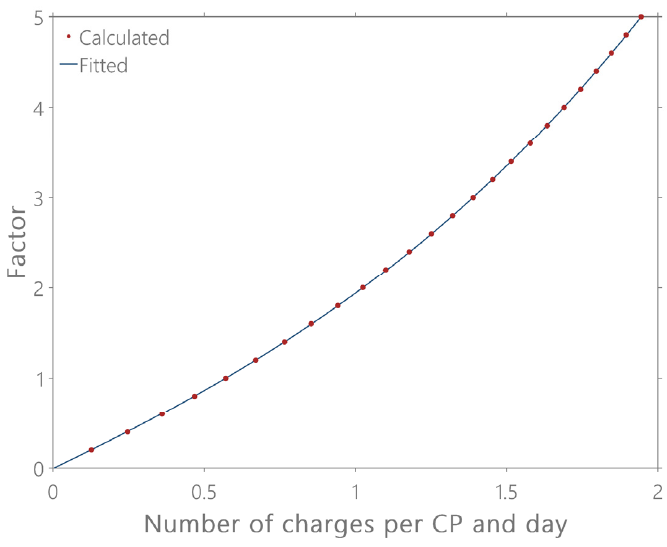
Figure 12. Determination of the factor for manipulating the start of charging probability.